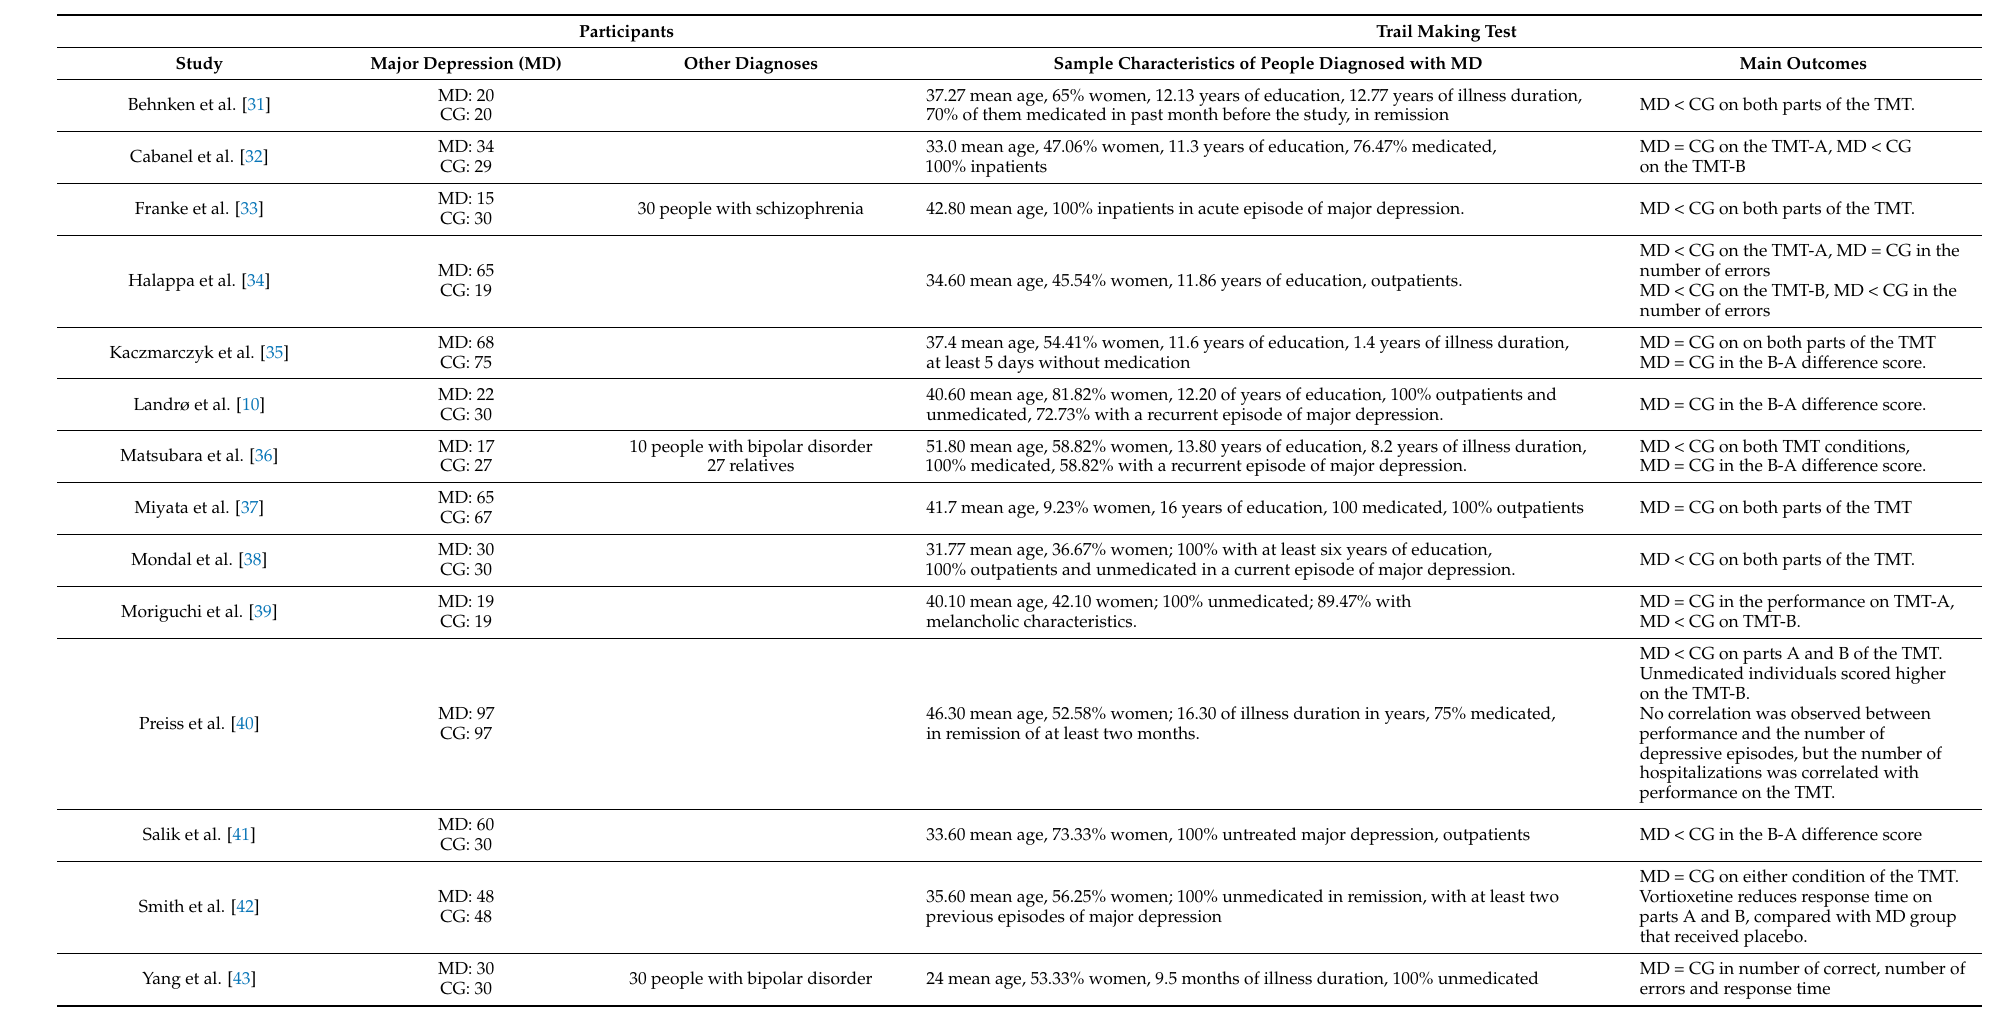
Table 1. Sample characteristics and main